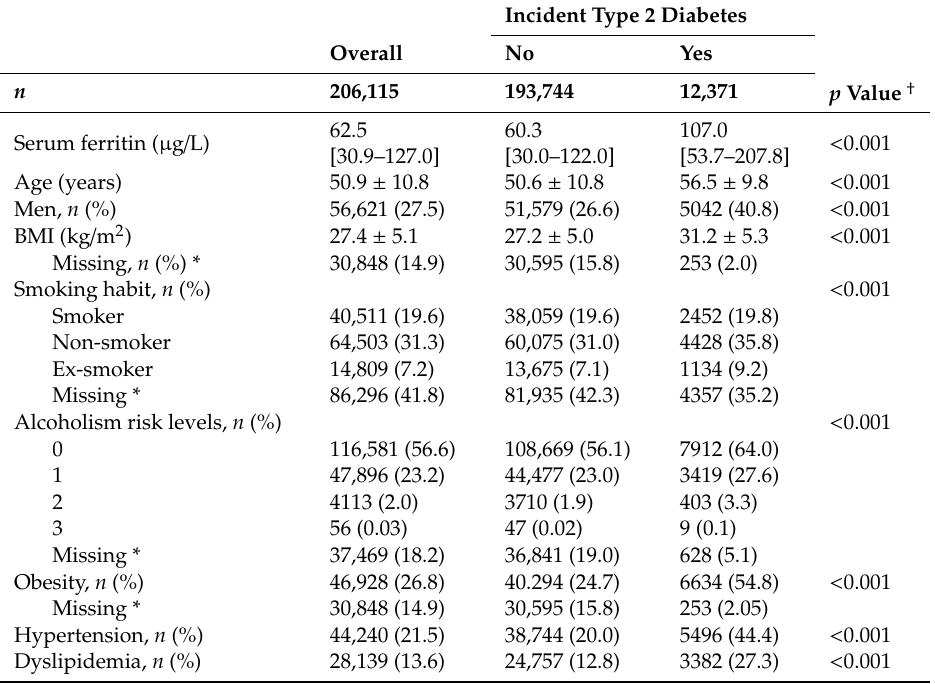
Table 1. Baseline characteristics of study subjects based on 8.4-year new-onset type 2 diabetes